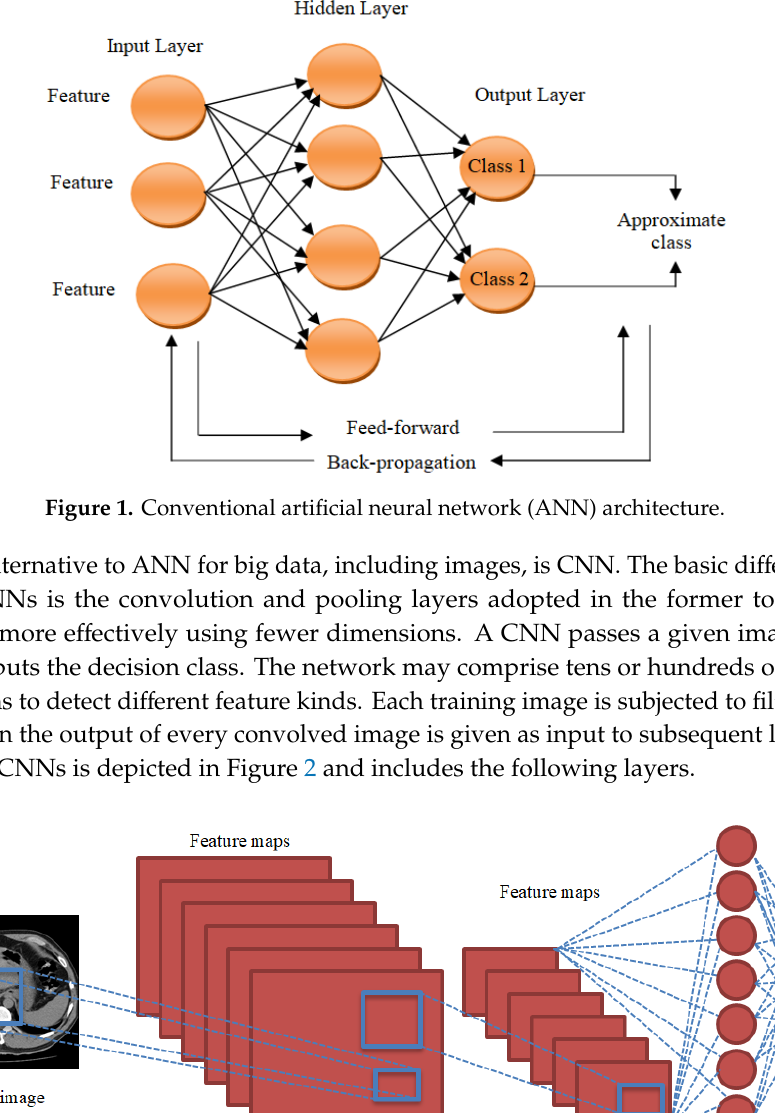
Figure 2. Basic architecture of a CNN showing its convolutional, pooling, fully connected, and output layers. The given image is passed through these layers to predict the decision class.